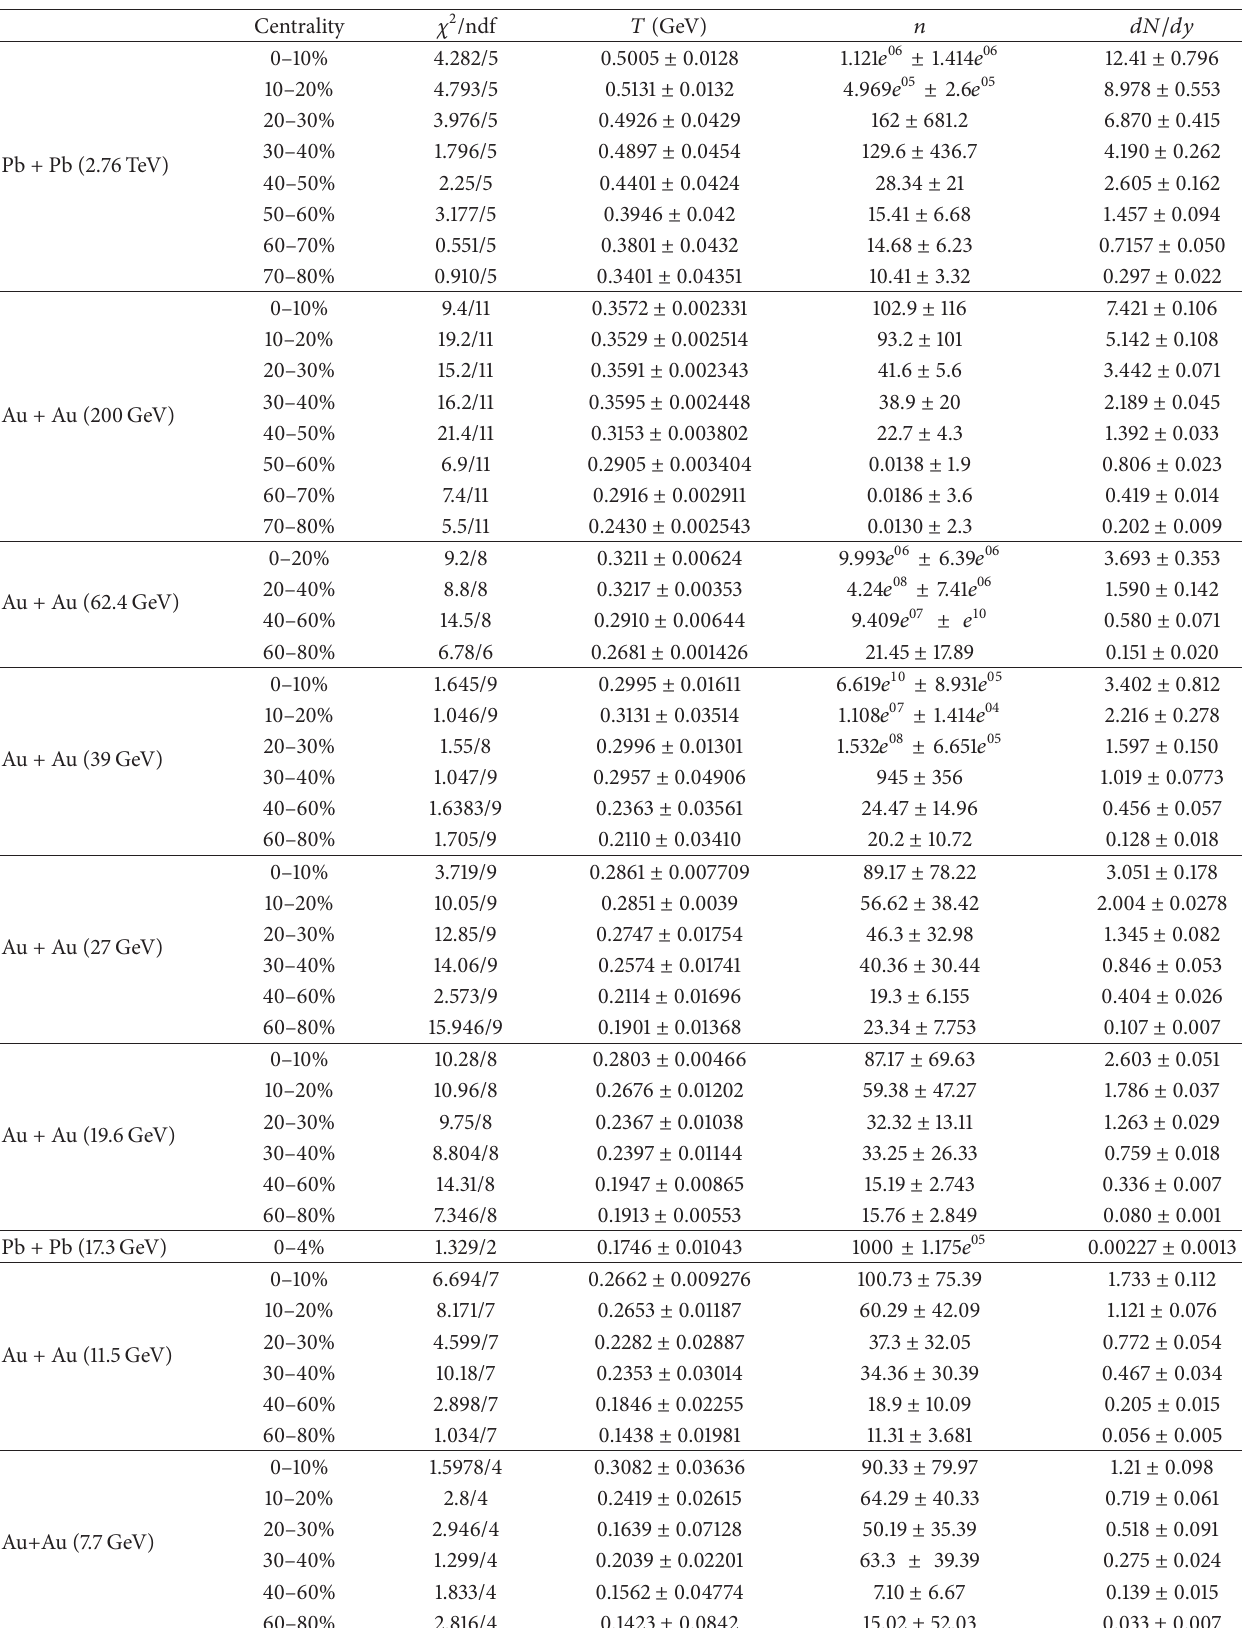
Table 1: Results from Levy fits to the transverse mass distributions of the 𝜙 meson. All values are for midrapidity ( |𝑦| < 0.5